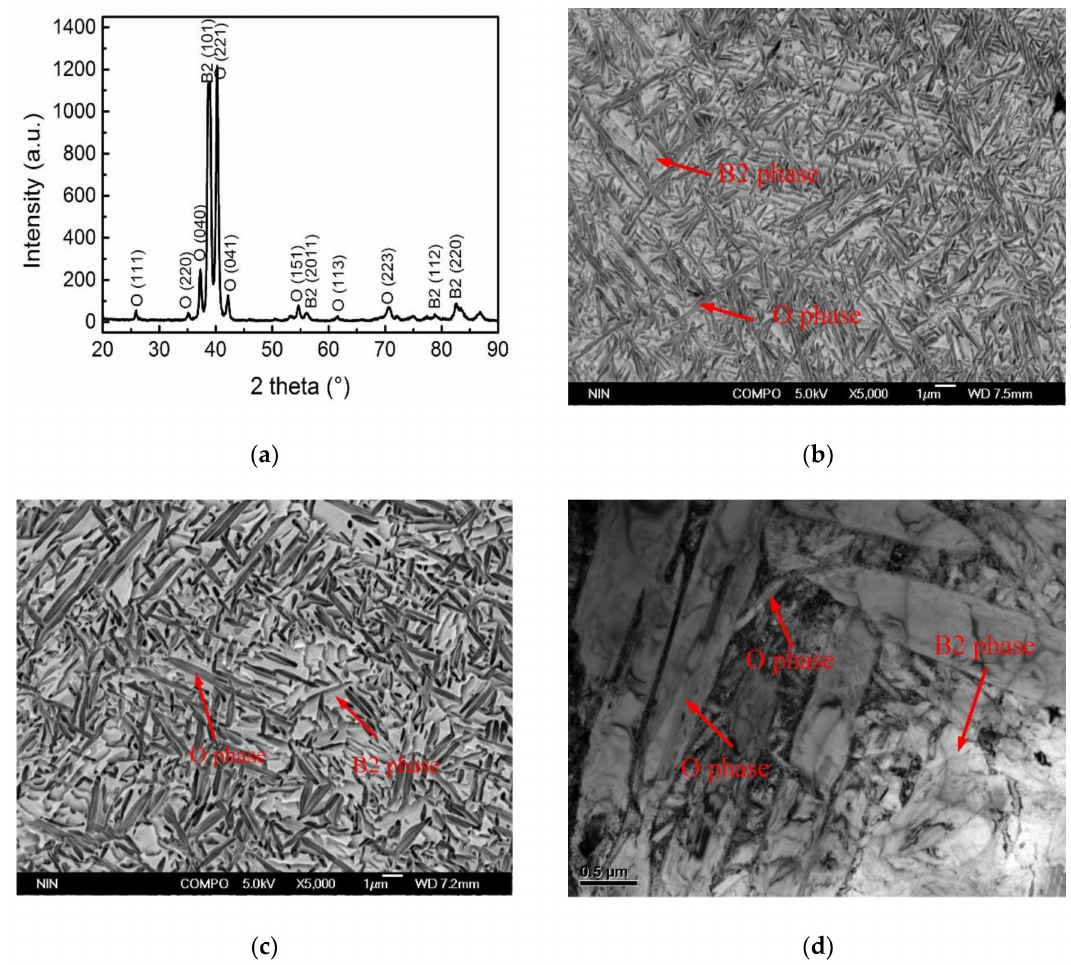
Figure 1. Phase and microstructure of the initial alloys: ( a ) X-ray diffraction (XRD) image of the forged and then heat treated alloy at 800 ◦ C, ( b ) scanning electron microscope (SEM) image of the forged alloys, ( c ) SEM image of the forged and then heat-treated alloys at 800 ◦ C, ( d ) transmission electron microscope (TEM) image of the forged and then heat treated alloys at 800 ◦ C (the gray is O phase and light regions are B2 in Figure